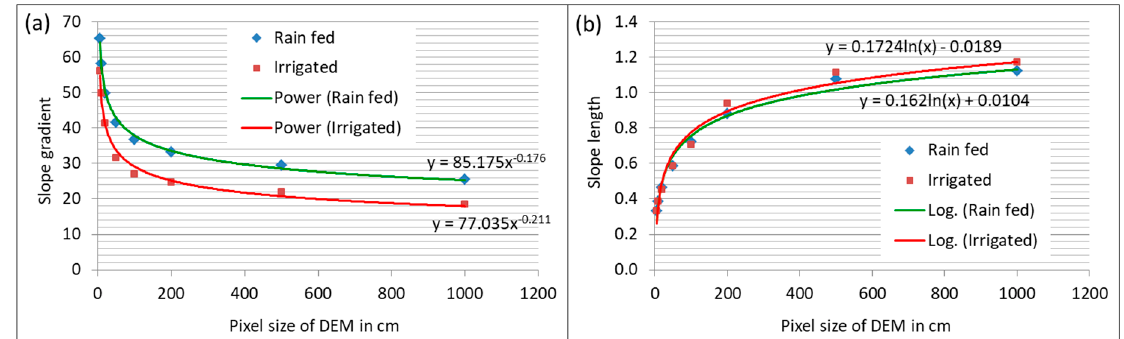
ISPRS Int. J. Geo-Inf. 2021 , 10 , x FOR PEER REVIEW Figure 3. Changing trend of slope gradient ( a ) and slope length ( b ) with the variation of DEM resolution.